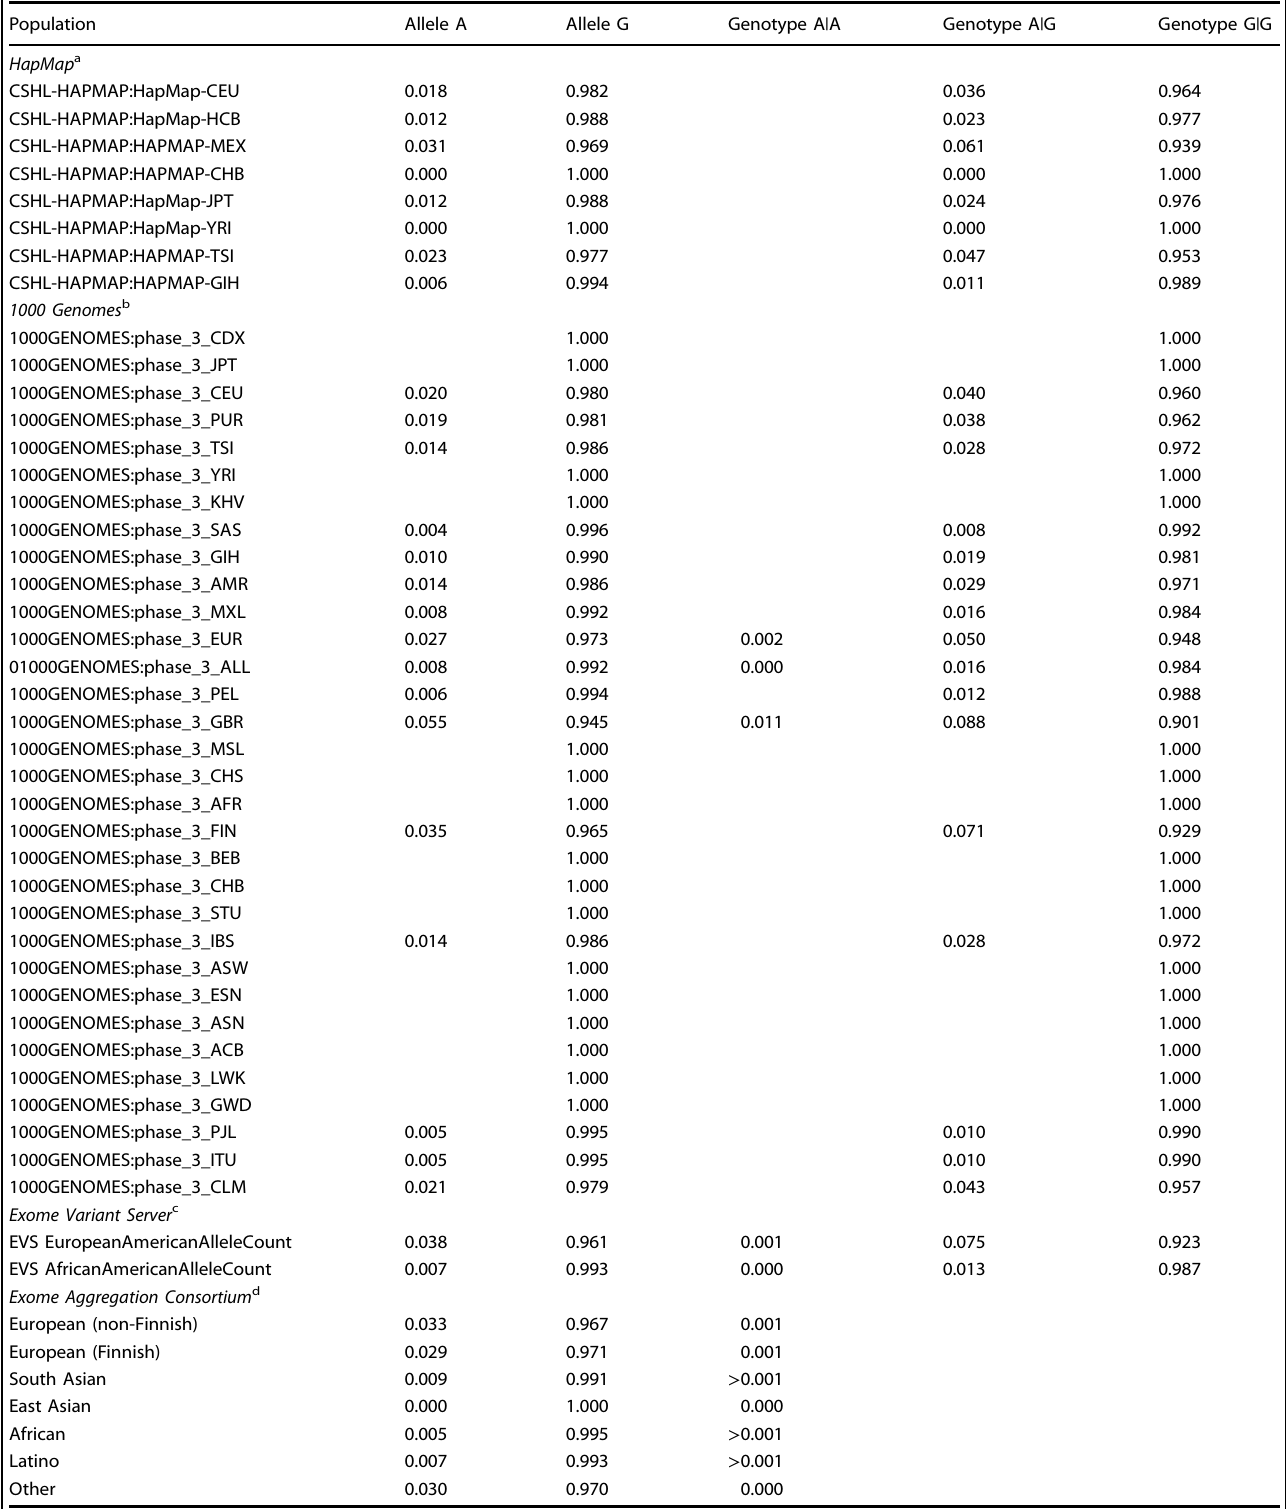
Table 1. Allele frequencies for HABP2 rs7080536 in HapMap, 1000 genomes, Exome Variant Server and ExAC databases Population Allele A Allele